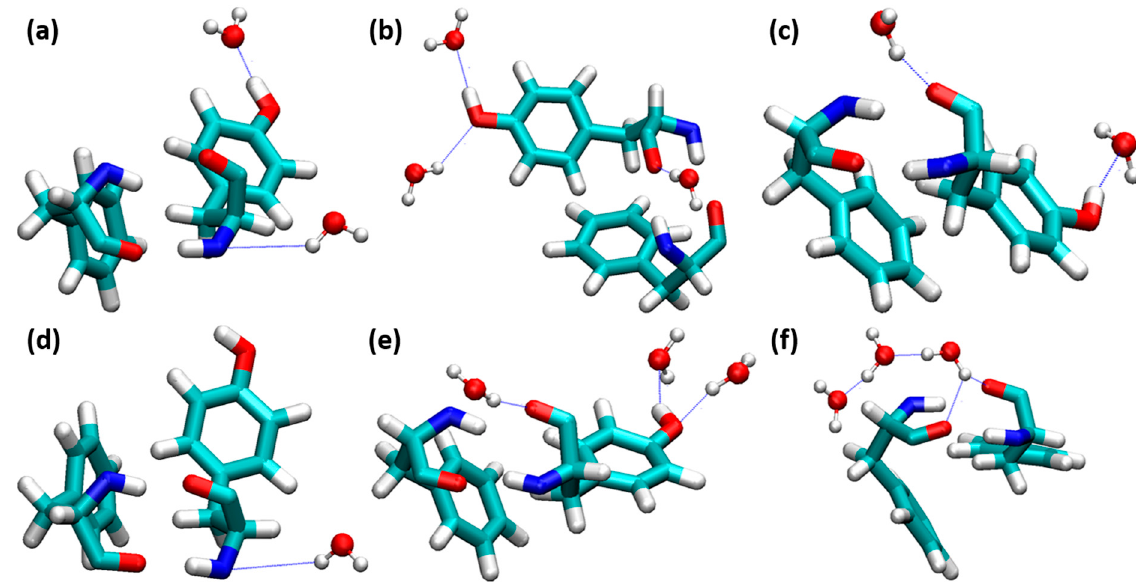
Figure 5. Water molecules interacted on the insulin dimer interface involving Phe B24 - Tyr D26 . ( a ) 0.10, ( b ) 0.20, ( c ) 0.40, ( d ) 0.60, ( e ) 0.80, and ( f ) 1.00 mole fractions of EtOH (Phe B24 -Tyr D26 and water molecules are depicted in the licorice and ball-and-stick models, respectively. H-bonds are shown as blue dotted lines).